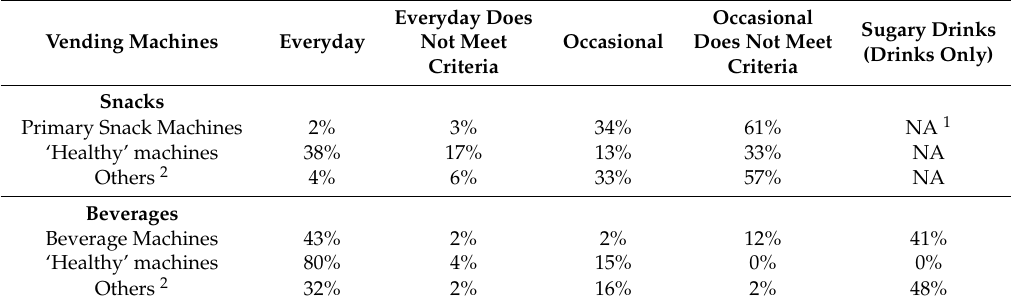
Table 4. Foods and drinks classification across all 30 audited food